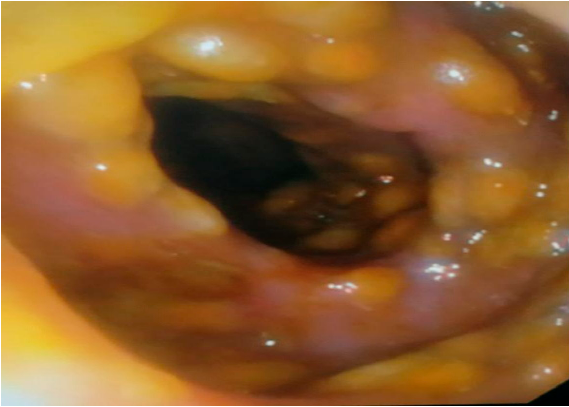
Figure 1. Endoscopic picture before FMT, personal collection.